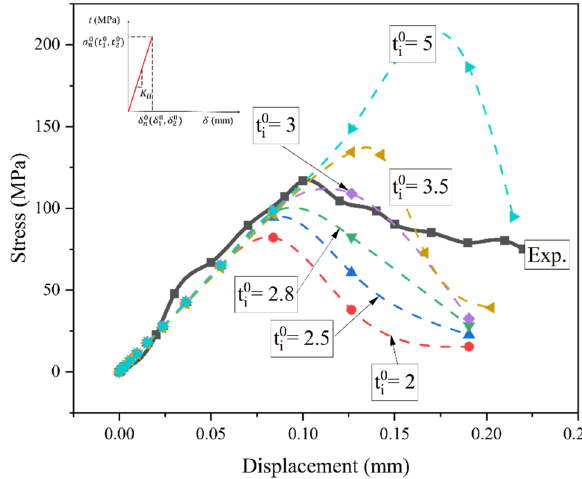
Figure 17: Determination of shear strength, t i 0 , according to the comparison of the experimental test and the predicted